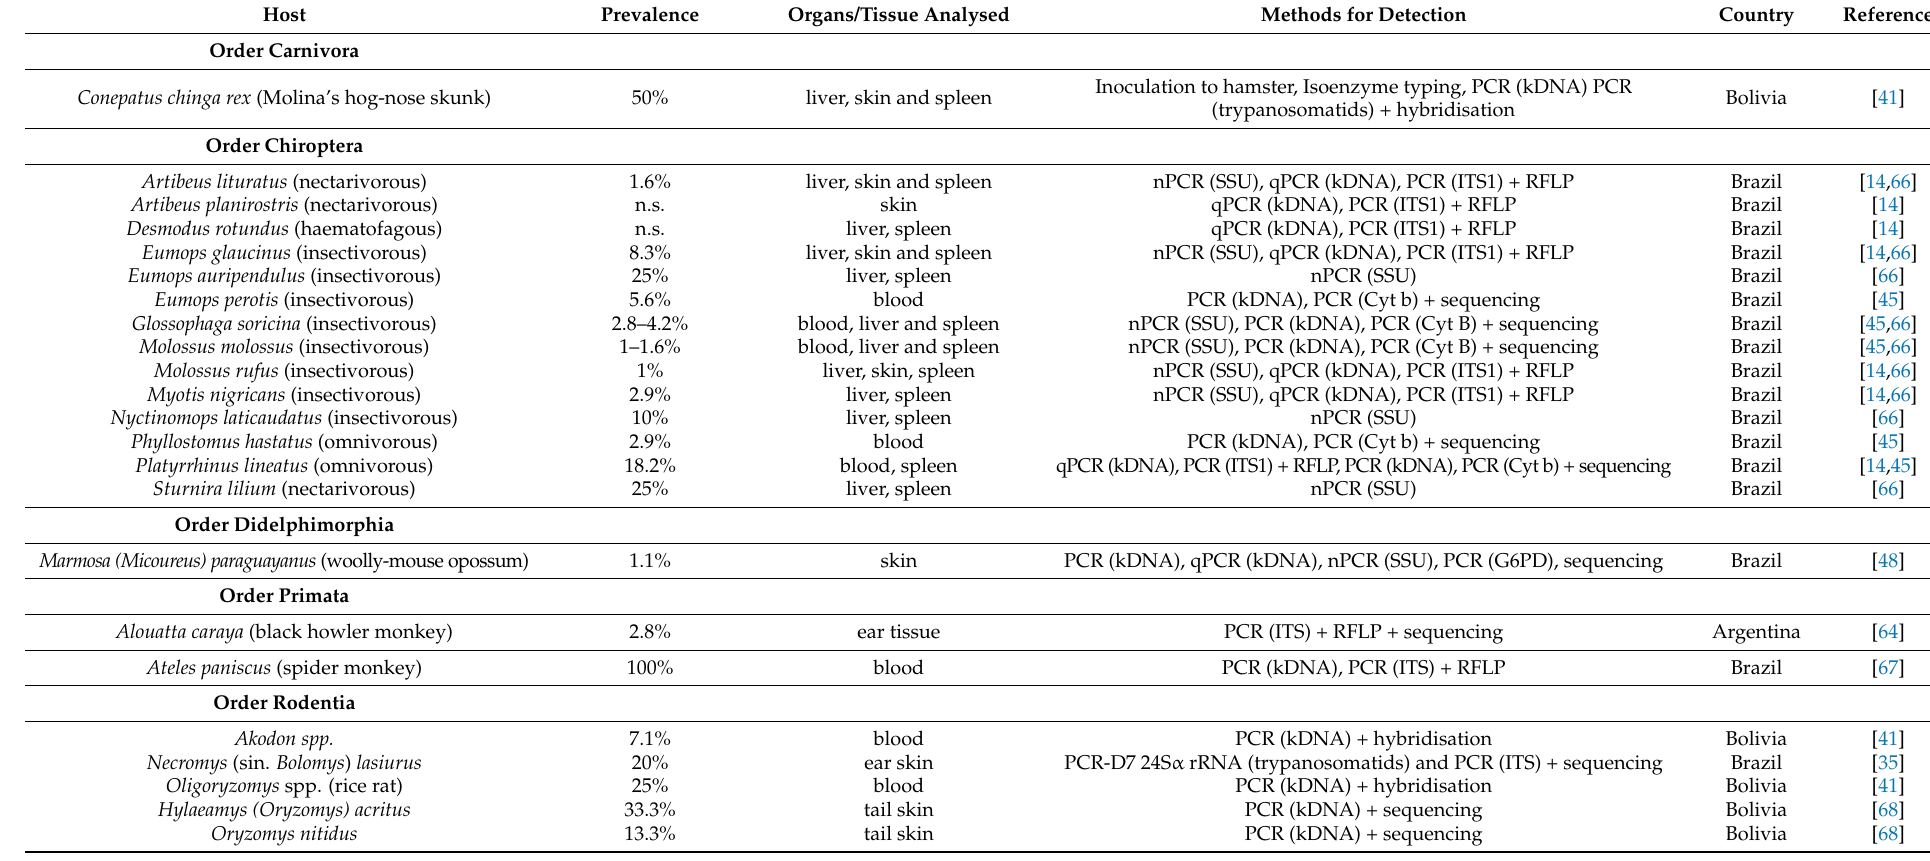
Table 3. Wildlife that reported positive for Leishmania amazonensis . Organs or tissues where the parasite was detected are indicated, as well as the techniques employed for